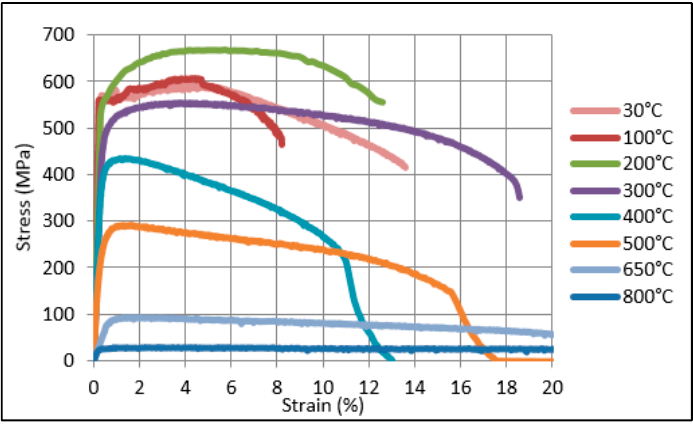
Figure 9. Stress–strain curve CFS at ambient and high temperature.